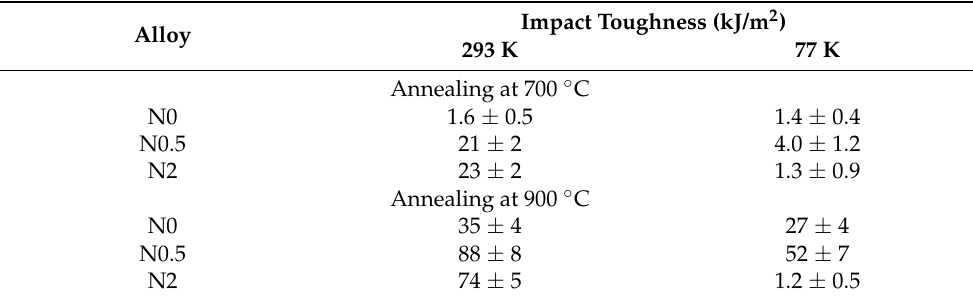
Table 6. Impact toughness of the Fe 40-x Mn 40 Cr 10 Co 10 N x alloys after rolling and annealing at 700 ◦ C and 900 ◦ C obtained at room and cryogenic temperatures.